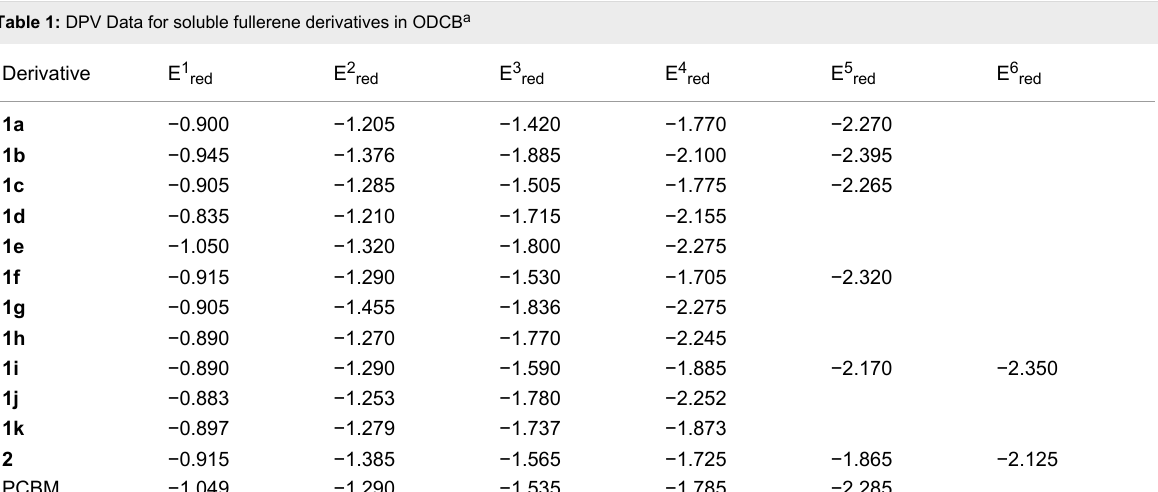
Table 1: DPV Data for soluble fullerene derivatives in ODCB a